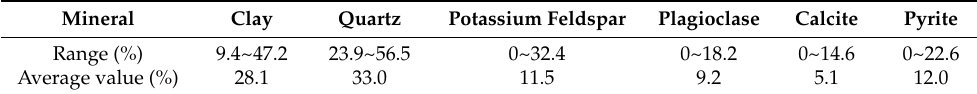
Figure 1. Geographical location characteristics of Ordos Basin and study area (modified from [30]). Table 1. Mineral components of Chang 7 3 shale oil reservoir in Ordos.